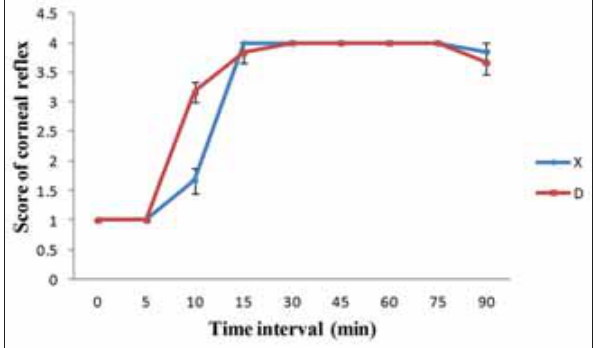
Figure-3: Mean±Standard error scores of corneal reflex in animals of different groups. *Significantly different from the base value (p<0.05). **Significantly different from the base value (p<0.01).